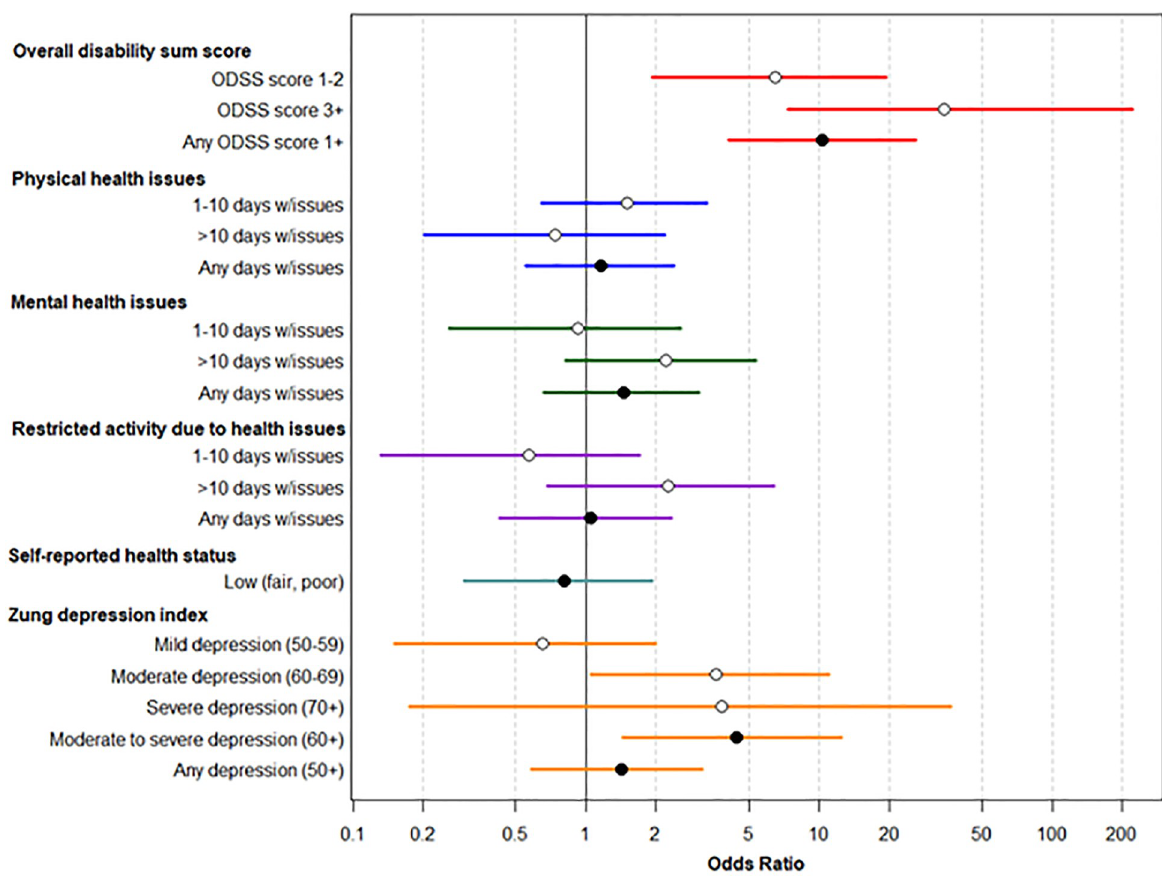
Fig 5. Comparison of disability of GBS cases at follow-up compared to non-GBS comparison group. Odds ratios are adjusted for age and sex. Reference categories for each measure are as following: ODSS (reference score = 0); physical health issues (reference of 0 days in last 30 days with issues); mental health issues (reference of 0 days in last 30 days with issues); restricted activity due to health issues (reference of 0 days in last 30 days with restricted activity); self-reported health status (reference of excellent, very good, or good status); Zung index (reference of score below 50). Empty circles represent comparisons of individual categories with the reference, while black circles represent comparisons of combined categories with the reference. Cases were more likely to have an overall disability sum score (ODSS) of 1 or more (0 indicates no disability) at follow-up compared to the comparison group, adjusted for age and sex. Cases had an odds ratio of 6.48 (95% confidence interval: 1.91, 14.92) of having an ODSS from 1–2 (as opposed to ODSS = 0) compared to the comparison group. The odds ratio for cases having ODSS of 3+ compared to the population comparison group was 34.38 (95% CI: 7.33, 221.95), and the odds ratio for cases having any ODSS score of 1 or more was 10.28 (95% CI: 4.09, 26.09). Cases were more likely to have moderate depression (Zung index between 60–69, as opposed to no depression, Zung index below 50) compared to the population comparison group, with an age- and sex- adjusted odds ratio of 3.81 (95% CI: 1.10, 11.59). Cases were also more likely to have moderate or severe depression (Zung index of 60+) than the population comparison group (odds ratio = 3.89, 95% CI: 1.23,